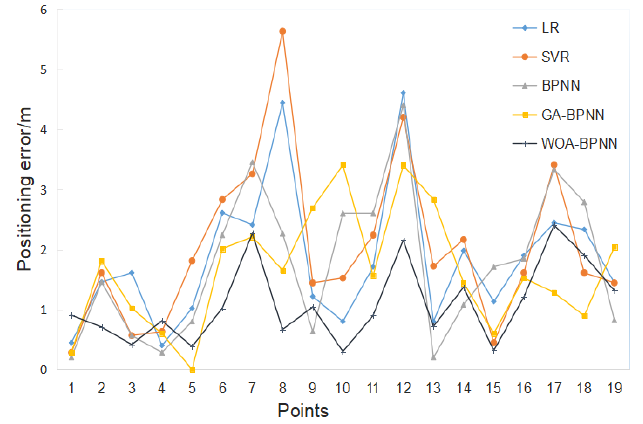
Figure 19. Comparison of positioning error of different algorithms.